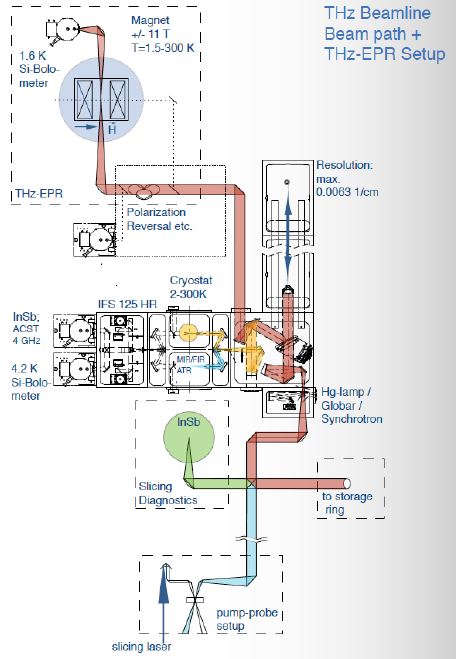
Figure 2: Optical layout of the FD-FT THz-EPR/THz spectroscopy user station. Red and orange: THz beam path of the FD-FT THz-EPR detection scheme through the sample magnet and through the sample cryostat, respectively, green: Slicing Diagnostics, blue: THz TDS pump-probe